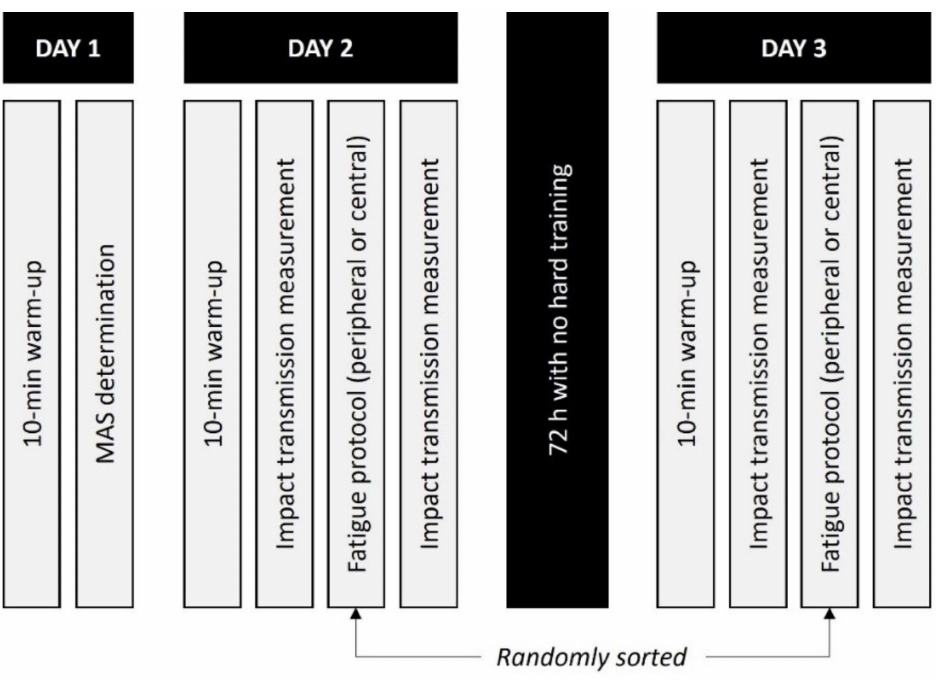
Figure 1. The experimental protocol followed in the